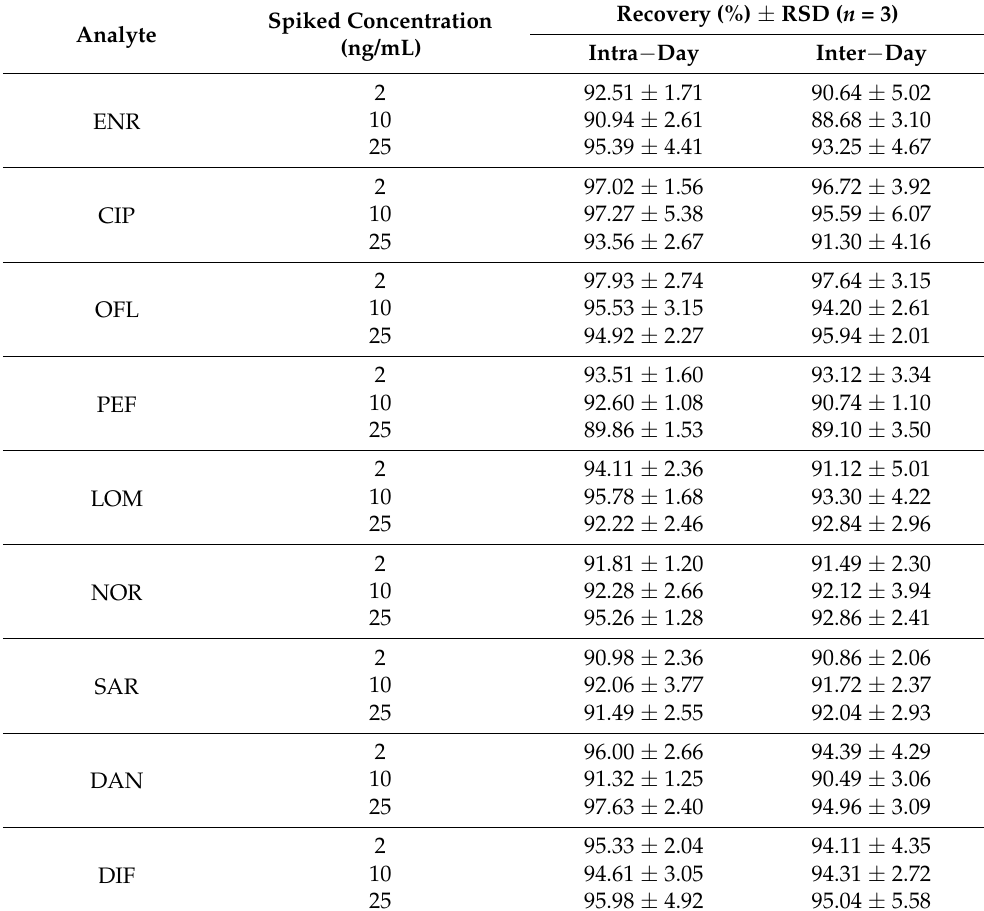
Table 3. Absolute recoveries of nine quinolones from pure milk samples via PFSPE − HPLC − MS/ MS analysis.